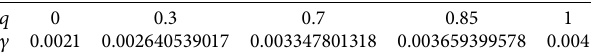
Table 6: Diferent values of d q 0 0 . 4 0 . 6 0 . 8